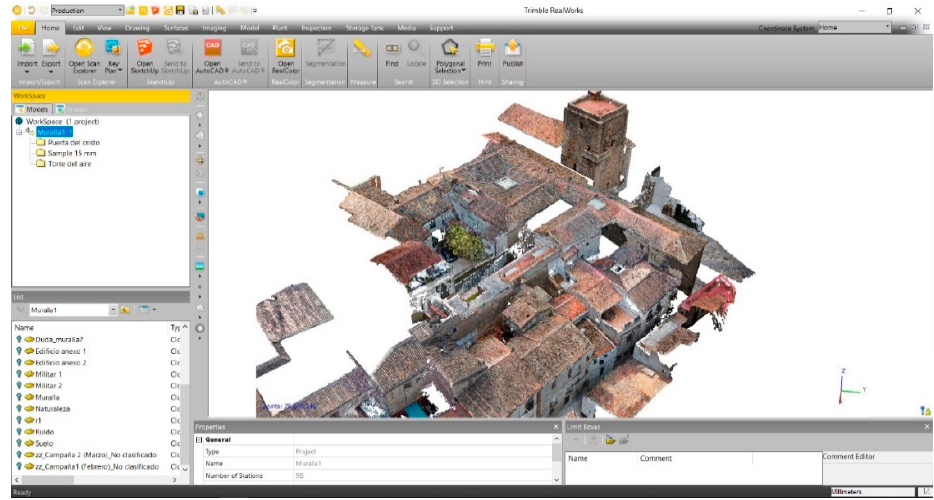
Figure 9. Classification of the point cloud with Trimble RealWorks software.